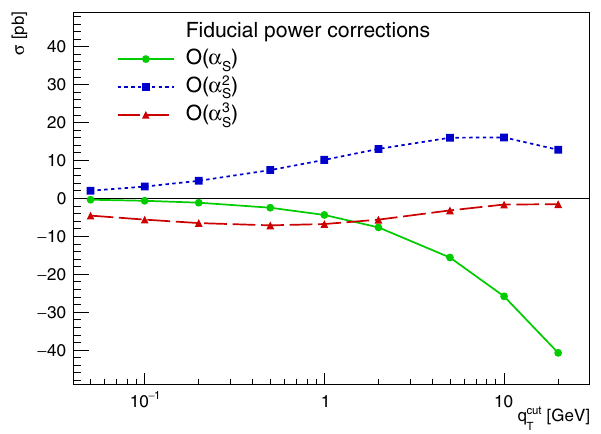
Fig. 4 Production of l + l − pairs from Z /γ ∗ decay at the LHC ( 13 TeV). Power correction contributions at O (α S ) , O (α 2 at various values of q cut T